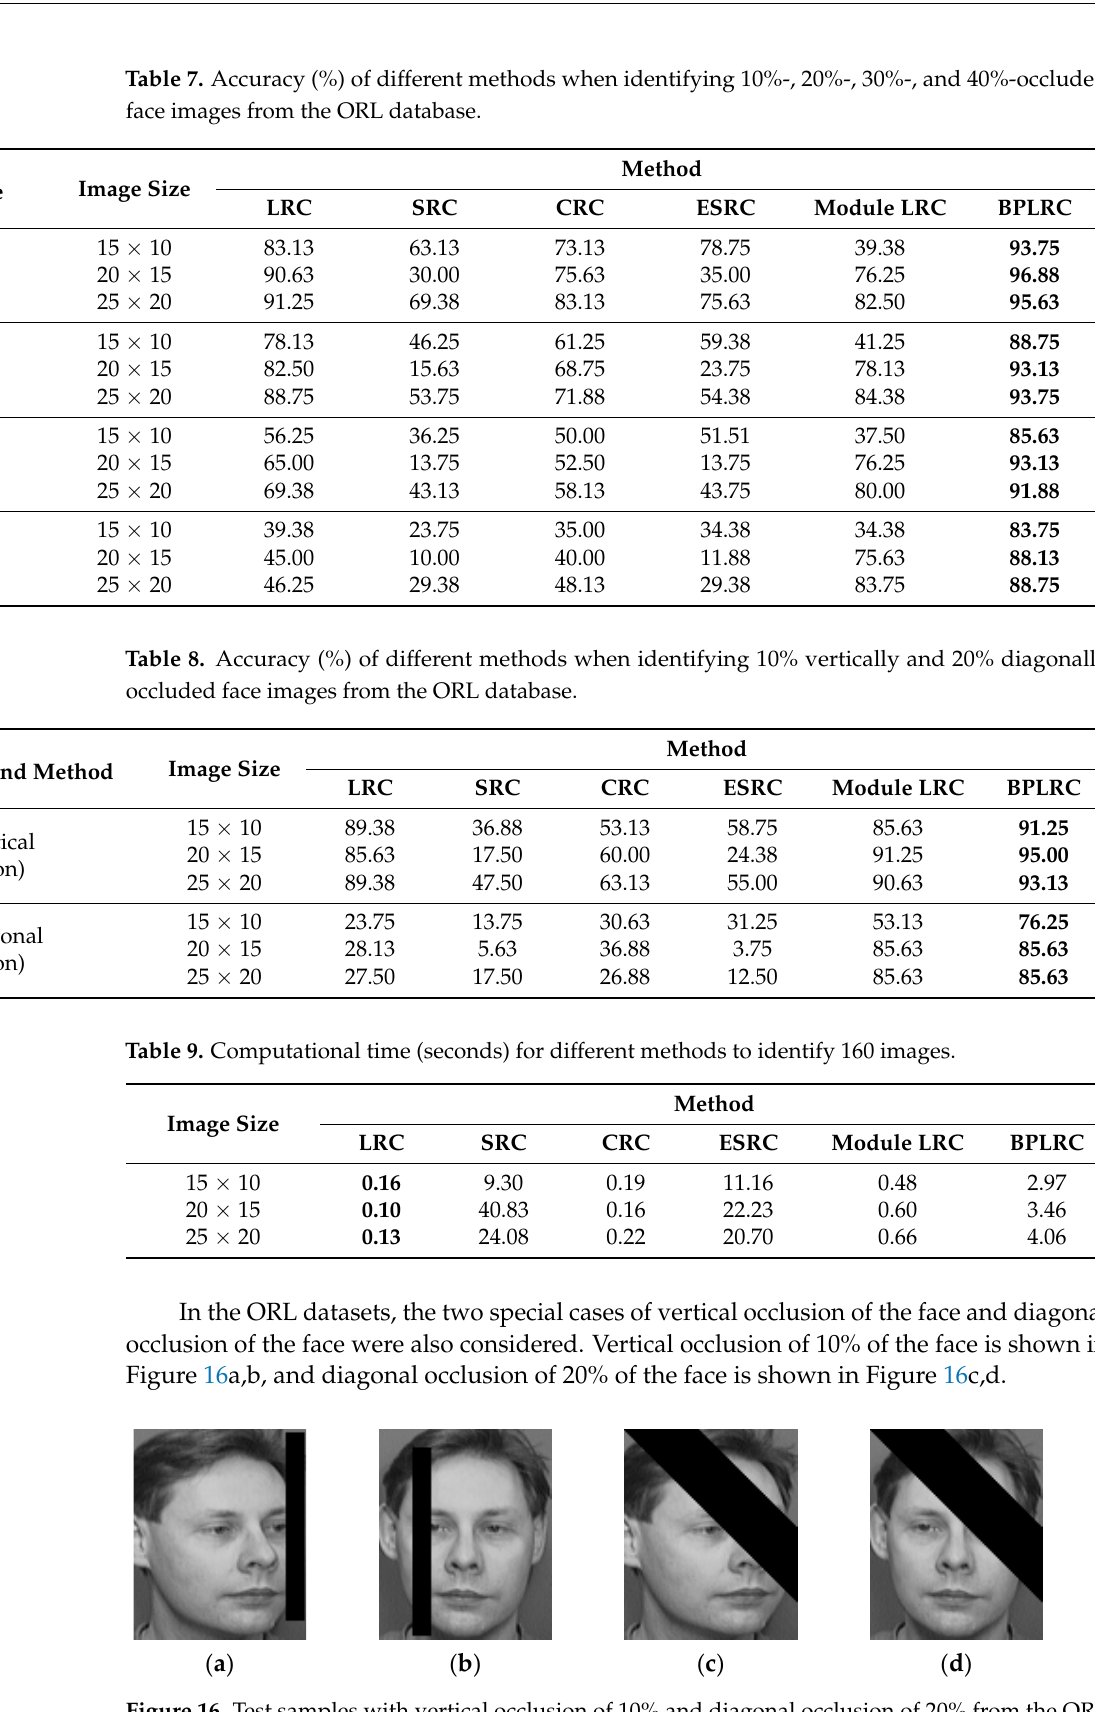
Figure 16. Test samples with vertical occlusion of 10% and diagonal occlusion of 20% from the ORL datasets: ( a , b ) face images with 10% vertical occlusion; ( c , d ) face images with 20% diagonal occlusion [ Reprinted with permission from Elsevier [20]. Copyright 2013, Neurocomputing ] .